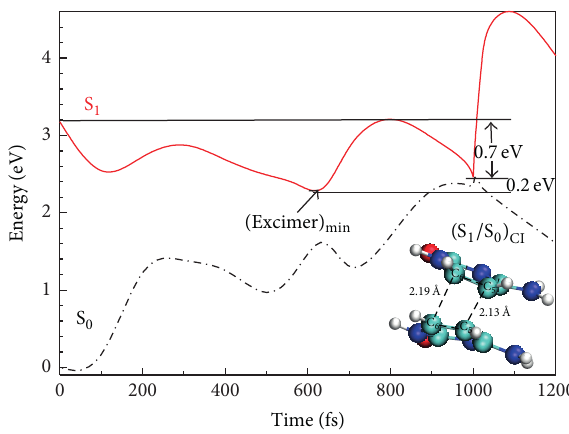
Figure 6: PES of stacked cytosines system at Cam-B3LYP/6-311+g ∗ level. Geometry of conical intersection is